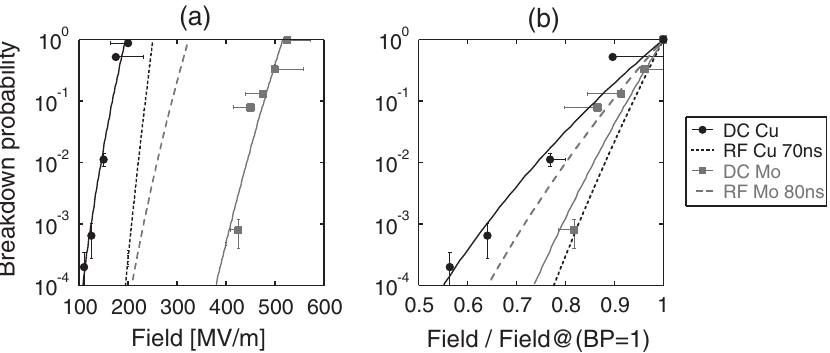
FIG. 11. Breakdown probability as a function of the applied electric field. Comparison of the dc results with rf 30 GHz results for Cu and Mo: (a) vs field; (b) vs normalized field at breakdown probability ¼ 1